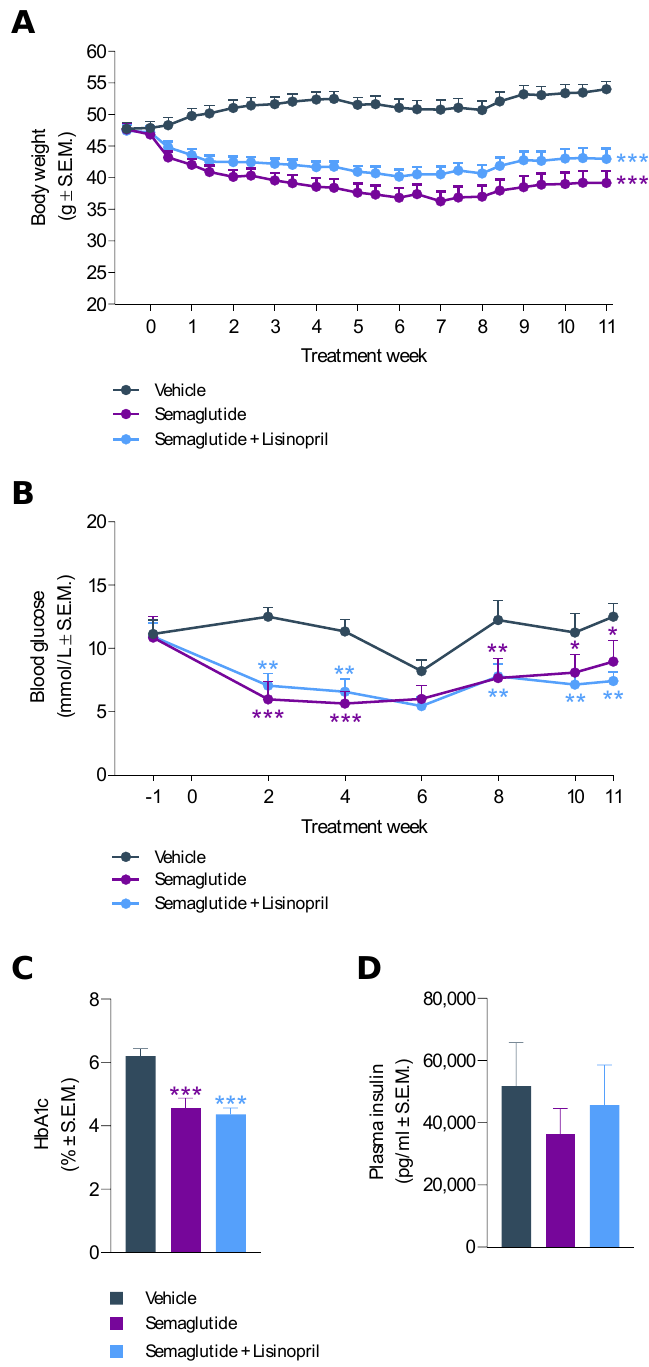
Figure 2. Semaglutide reduces body weight and improves hyperglycemia in db / db UNx-ReninAAV mice. ( A ) Body weight. ( B ) Fed blood glucose levels. ( C ) Terminal HbA1c levels. ( D ) Terminal plasma insulin concentrations. Semaglutide monotherapy (30 nmol/kg, s.c., q.d., n = 15) and combination treatment with lisinopril (30 mg/kg, p.o. q.d., n = 14) was performed for 11 weeks in db / db UNx-ReninAAV mice. Vehicle-dosed (s.c., q.d.) db / db UNx-ReninAAV mice ( n = 15) served as controls. * p < 0.05, ** p < 0.01, *** p < 0.001 vs. vehicle-dosed db / db UNx-ReninAAV mice (Dunnett’s test one-factor/two-factor linear model with interaction).